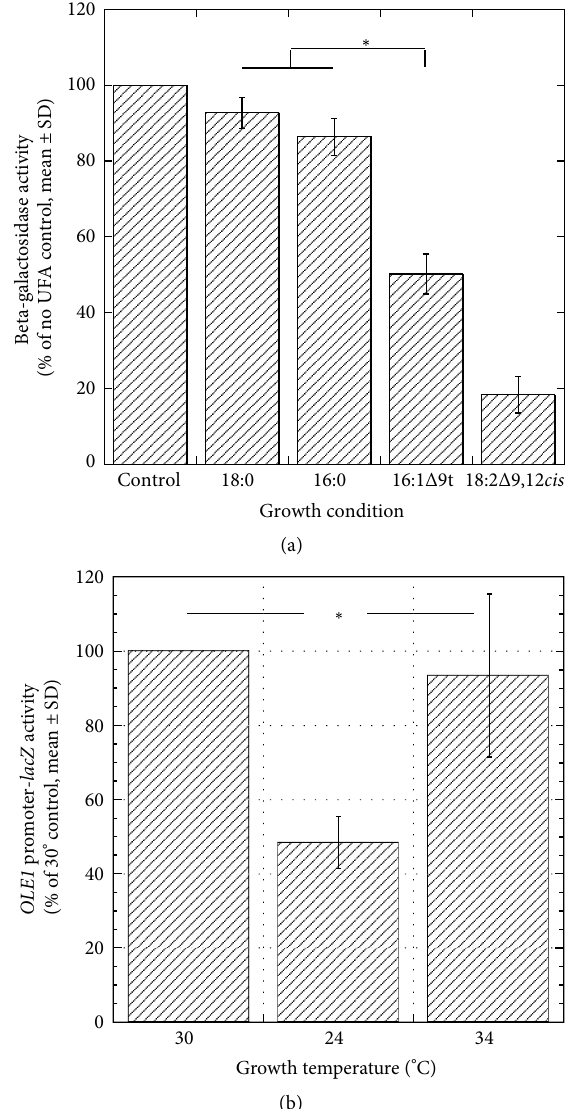
Figure 3: Effect of membrane altering conditions on OLE1 expression in wild type cells. Conditions thought to affect membrane fluidity were examined. Wild type W303-1A cells containing the OLE1-lacZ p62 reporter plasmid were grown overnight in YNBt (1% tergitol) and refreshed into noted condition for four hours. Cells were harvested and β -galactosidase activity determined. At least 5 replicates were performed for each growth condition. (a) Effect of growth on OLE1 expression in minus (“control”) or plus saturated or trans fatty acids (18:2∆9,12 cis is included as positive control). (b) Effect of temperature was examined on OLE1 expression. 30°C is the normal growth temperature of yeast under laboratory conditions, and was used as the “control” condition. Asterisk indicates significant difference ( 푝 < 0.05